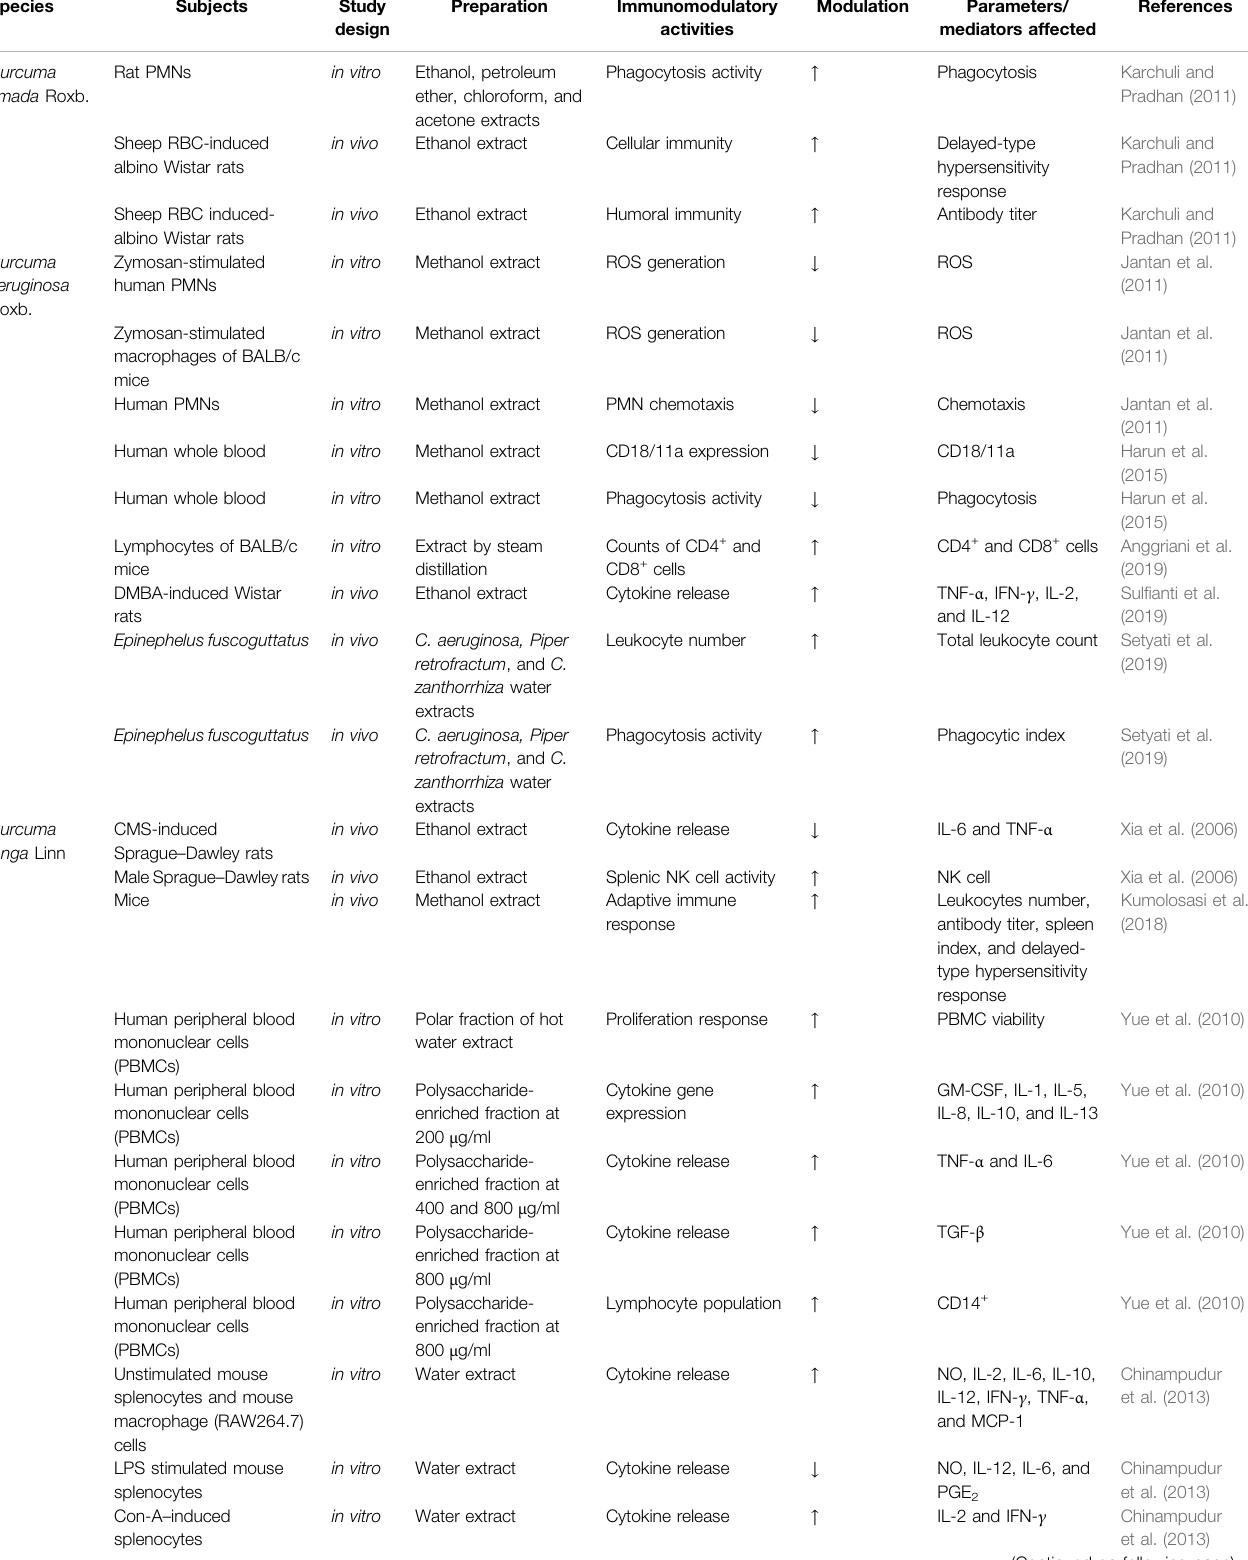
TABLE 1 | Immunomodulatory activity of some Curcuma species.